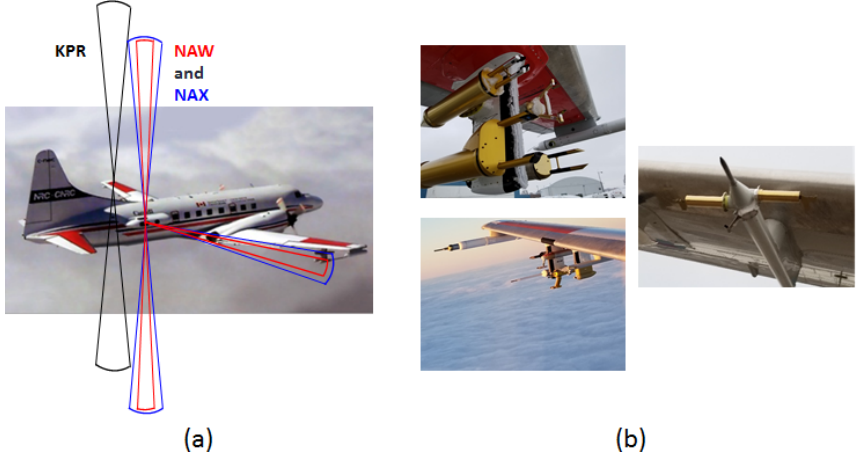
Figure 2. (a) Locations and direction of the NRC airborne W-band (NAW) and X-band (NAX) radars and antenna beams as well as (b) wing-mounted microphysics sensors and air data